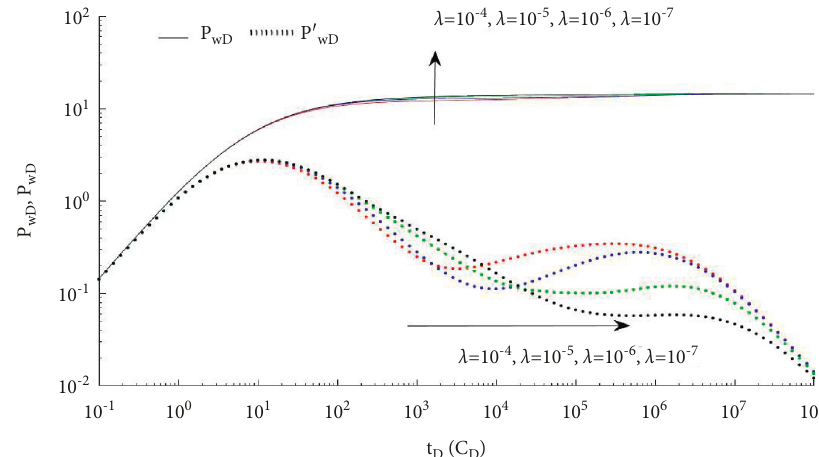
Figure 10: Dimensionless pressure of vertical wells under the constant value outer boundary influenced by λ ( C